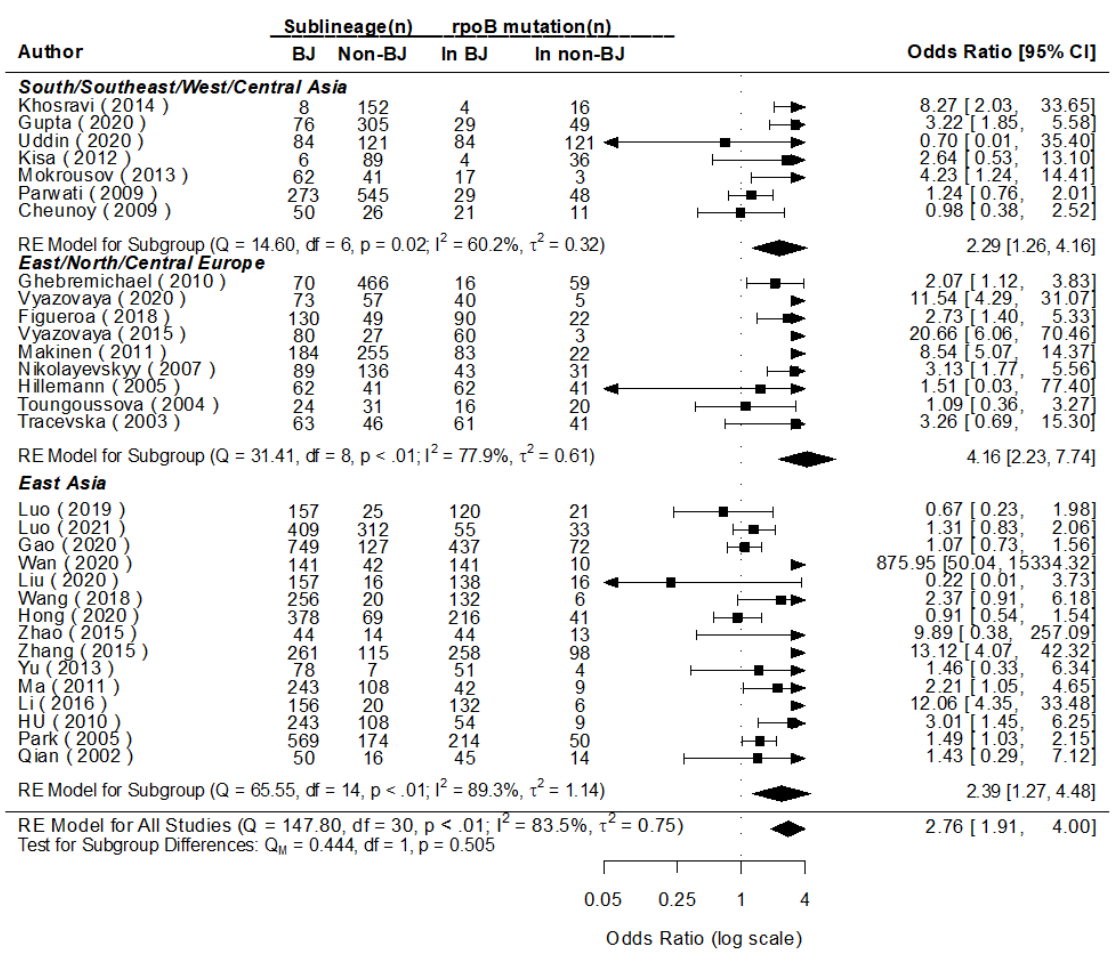
Figure 4. MA for the mutations of rpoB in Beijing and non-Beijing Strains (CI: confidence interval; BJ: Beijing strain; Non-BJ: non-Beijing strain).